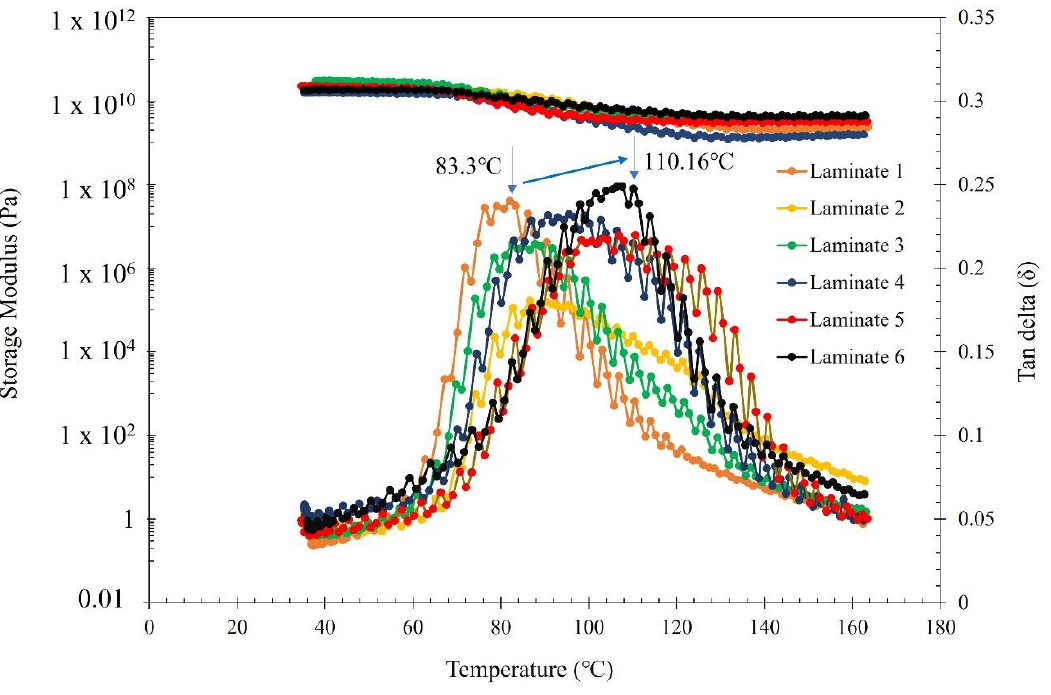
Figure 10. Storage modulus and tan δ as a function of temperature for laminates fabricated in the present study.